Question: Draft a figure caption describing what is shown.
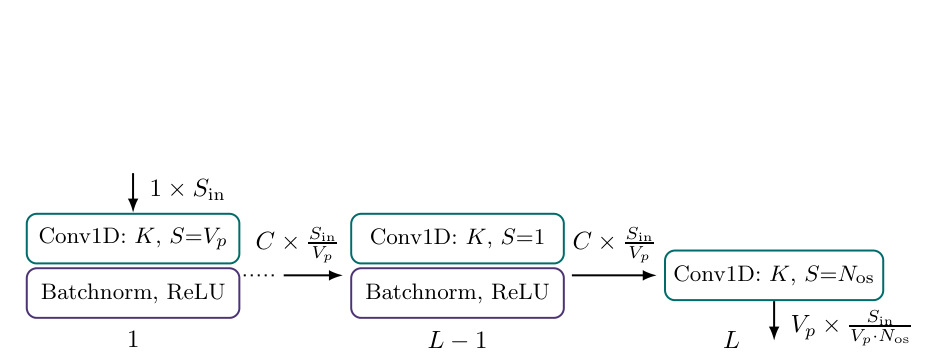
Answer: Topology template of the equalizer CNN. The feature map dimensions are given next to the arrows, where the ﬁrst dimension corresponds to the number of channels and the second one to the width.